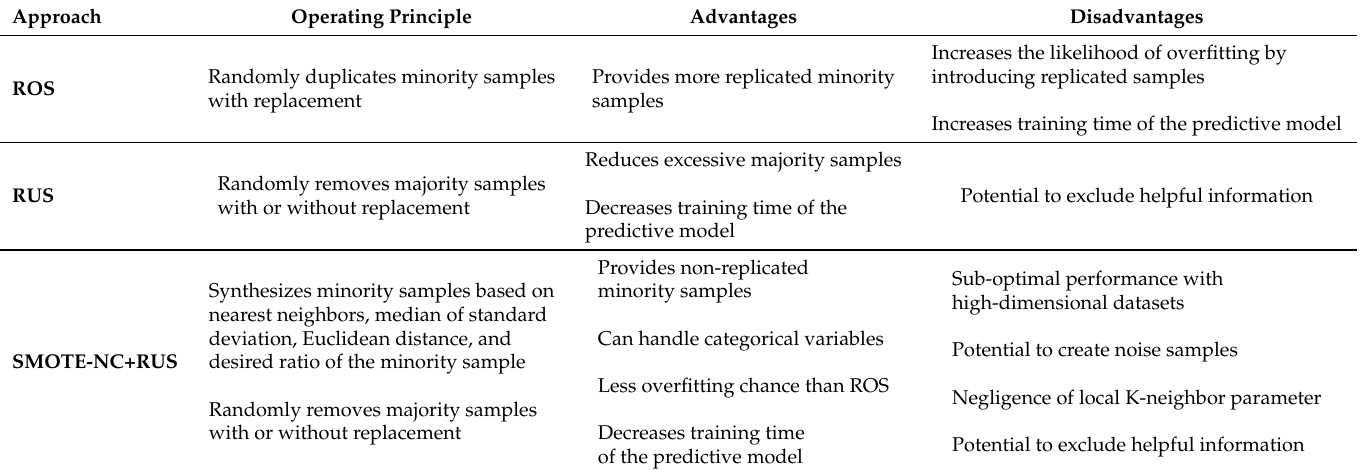
Table 1. The comparison of resampling techniques utilized in this